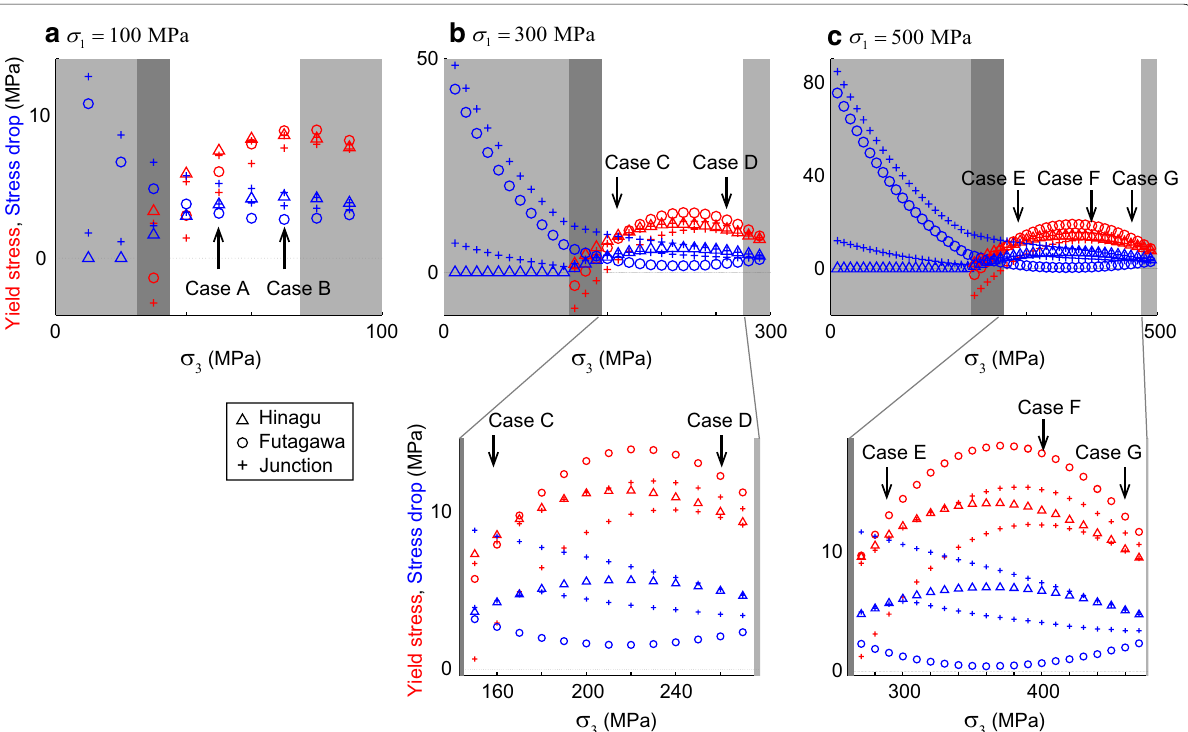
Fig. 6 Yield stresses (red) and stress drops (blue) as a function of σ 3 for a σ 1 value of a 100, b 300, and c 500 MPa. S H was set to be 2.0 in the calcula- tions of the yield stresses. Triangles and circles indicate the values of the Hinagu and Futagawa faults, respectively. Crosses indicate the maximum and minimum values of the junction elements for each σ 3 . For low σ 3 values indicated in light gray, τ r is much higher on the Futagawa fault than on the Hinagu fault, and thus, the seismic moment (i.e., stress drop) in the Futagawa fault should have been larger than the observed seismic moment even if the stress drop on the Hinagu Fault is zero. For low σ 3 values indicated in dark gray, the yield stress is negative. For high σ 3 values indicated in gray, the regional shear stress τ r is smaller than the static shear stress change due to the three foreshocks. Therefore, white regions correspond to the feasible σ 3 values. The bottom panels are enlarged figures of the white region in the top